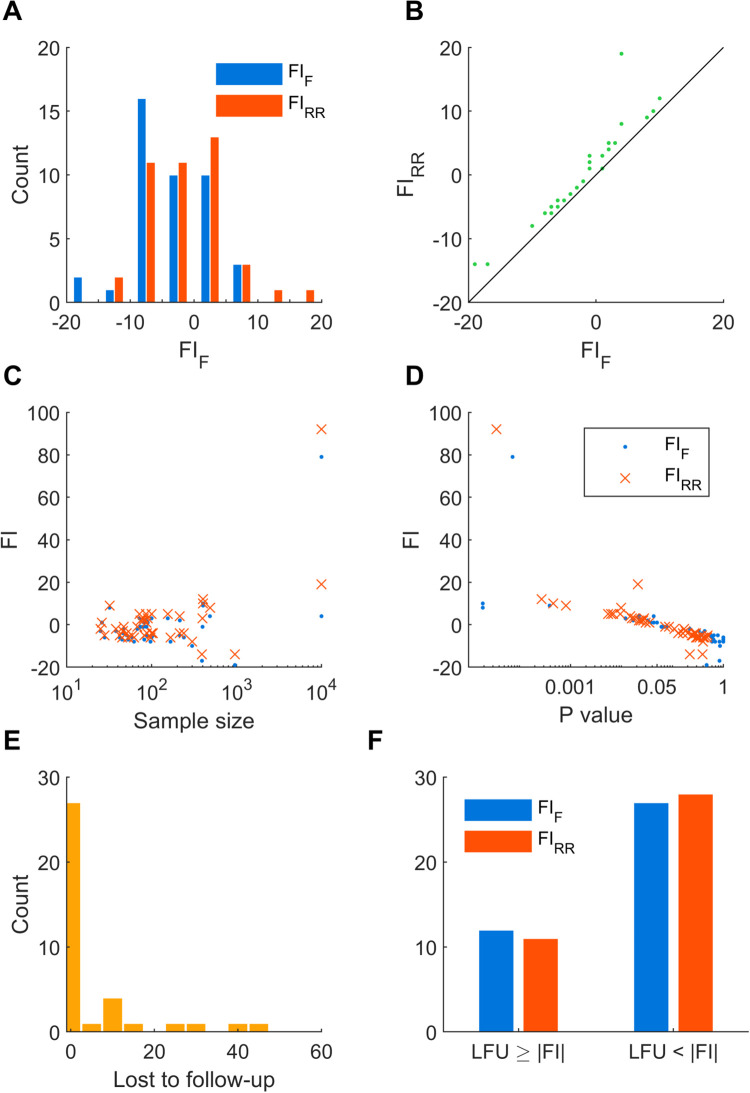
Fragility index analysis of the TBI guidelines.(A) Histograms showing the distribution of FIF (blue) and FIRR (red). One outlier is not shown, corresponding to Study ID 23 (see S2 Table in S1 File) with FIF and FIRR equal to 79 and 92, respectively. (B) The relationship between FIRR and FIF is shown. The black line corresponds to equality. Most values for FIRR lie above this line, indicating that FIRR > FIF for these cases. (C) The relationship between FI (FIF, blue dot; FIRR, red cross) and sample size. The horizontal axis is scaled logarithmically. (D) The relationship between FI (FIF, blue dot; FIRR, red cross) and P value. The horizontal axis is scaled logarithmically. (E) Histogram showing the distribution of the number lost to follow-up. (F) Comparisons of the number lost to follow-up (LFU) and the magnitude of FI.